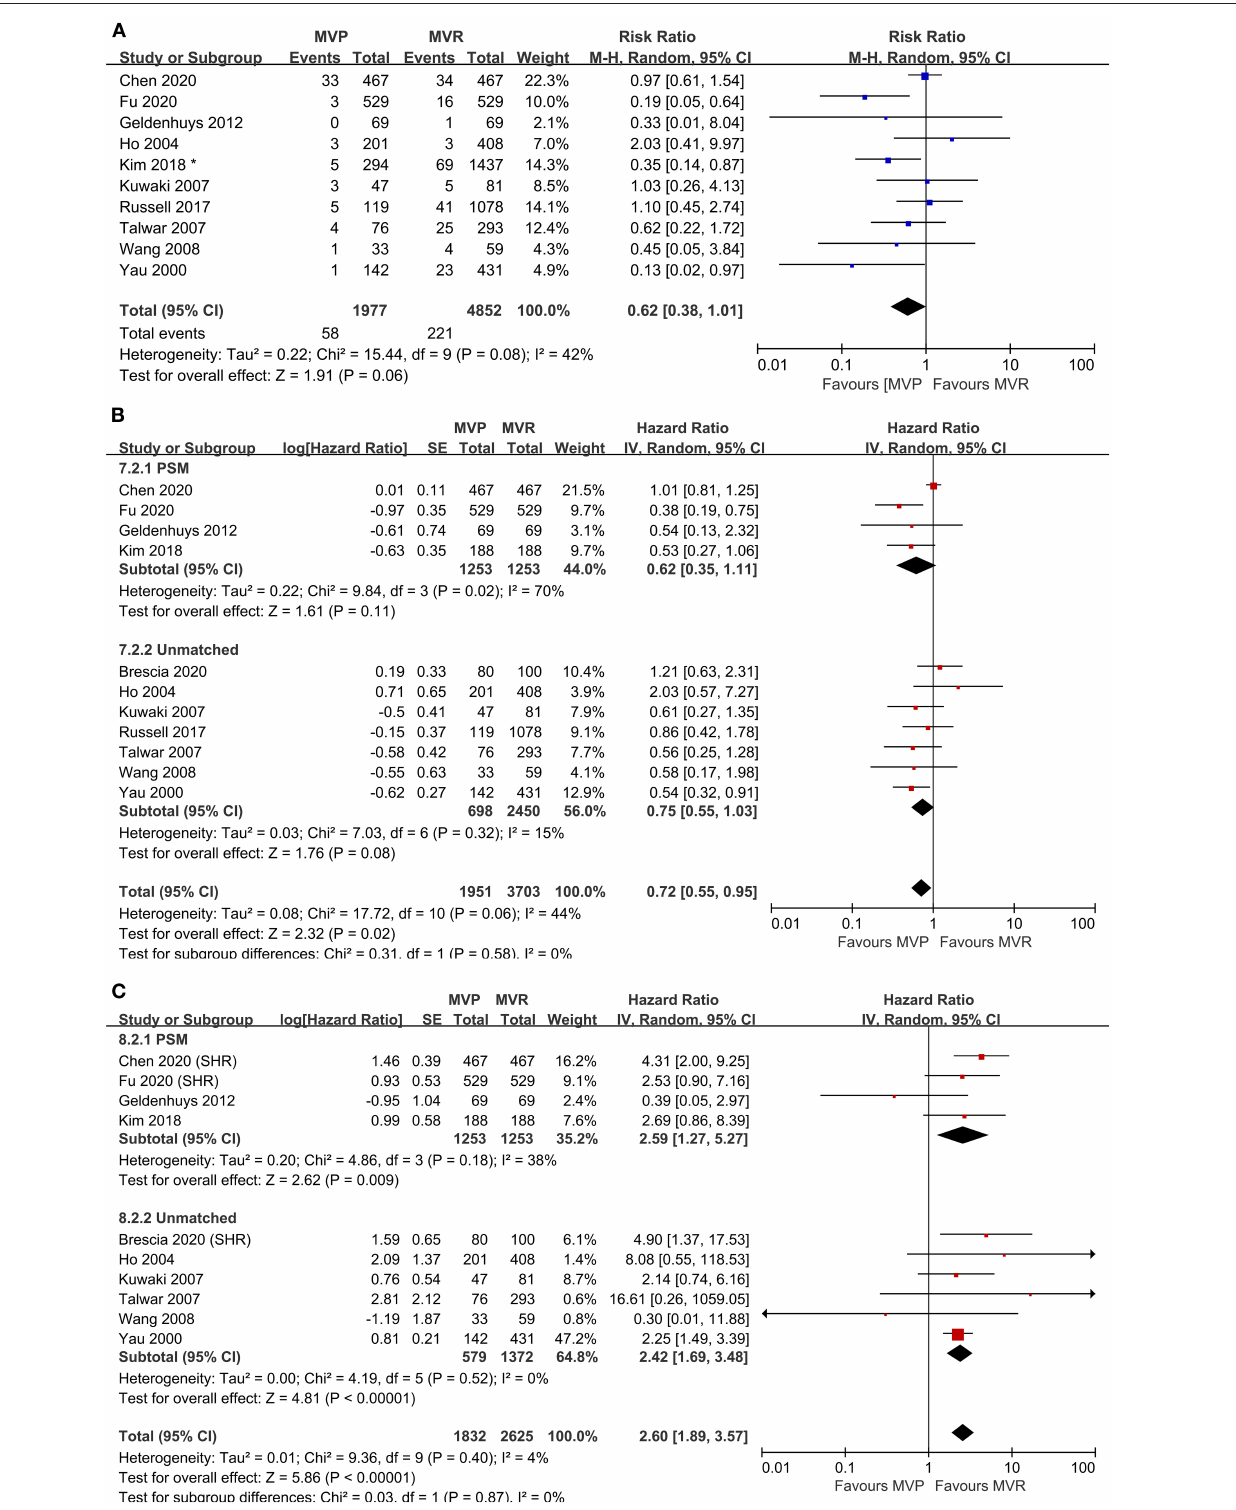
Frontiers in Cardiovascular Medicine |